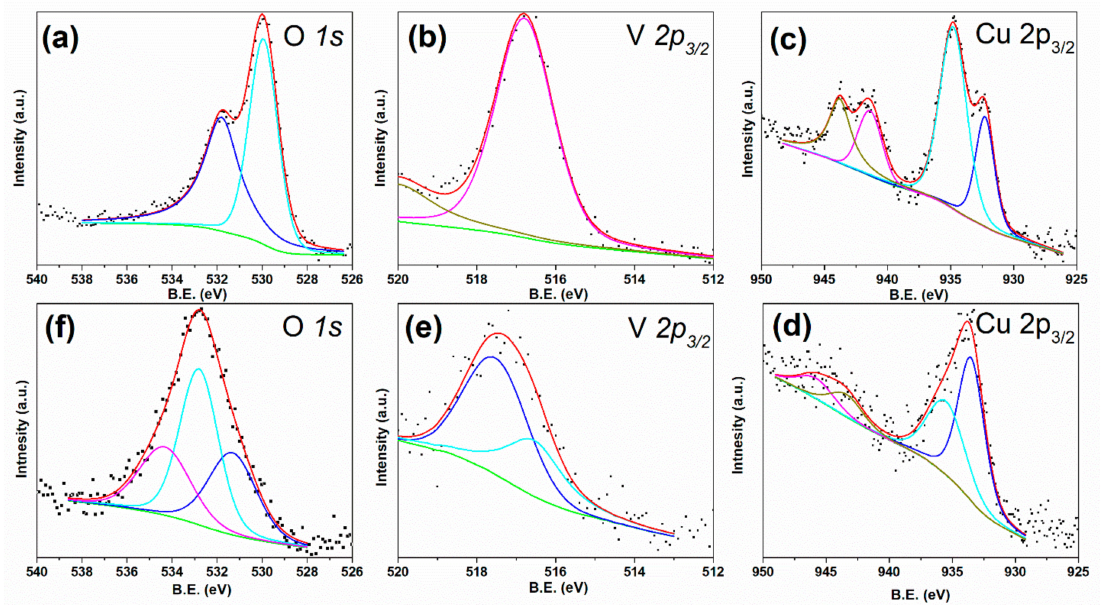
Figure 4. Spectroscopy (XPS) spectra of as-prepared β -Cu 2 V 2 O 7 /TiO 2 ( a – c ); and r-GO/ β -Cu 2 V 2 O 7 /TiO 2 ( d – f )